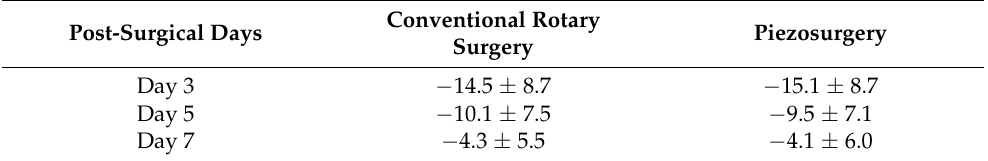
Table 3. Quantification of trismus on the third, fifth and seventh postoperative days in both surgical techniques.